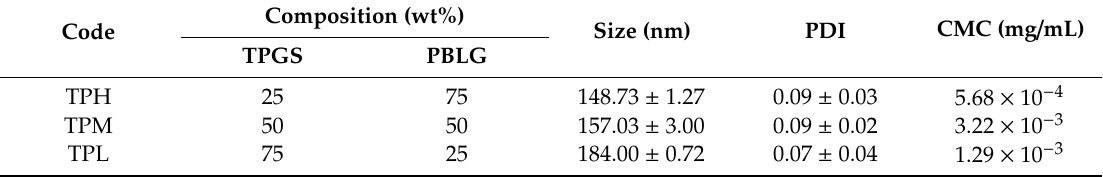
Table 1. The particle sizes and distributions of the mixed micelles with various